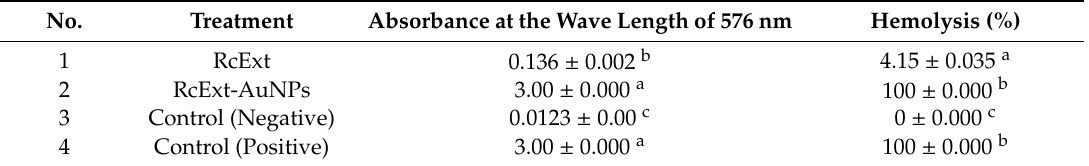
Table 5. The lytic effect of Ricinus communis ethanol leaf extract (RcExt) and extract with gold nanoparticles (RcExt-AuNPs) on red blood cells (RBCs).